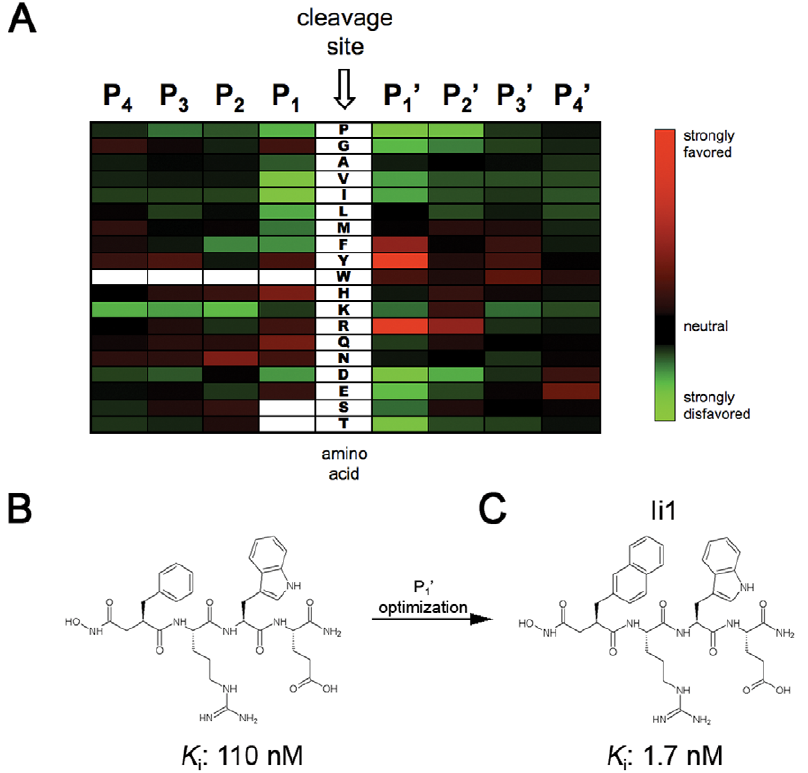
Figure 1. Cleavage-site specificity of IDE and first-generation inhibitors derived therefrom. A , Heat map showing amino acids favored ( red ) or disfavored ( green ) by IDE at different positions relative to the cleavage site, as determined from proteomic analysis of peptide mixtures. B , Conventional peptide hydroxamate synthesized on the basis of the analysis in ( A ). C , Structure of inhibitor Ii1, incorporating optimized P 1 ’ moiety deduced from analysis of a focused library of retro-inverso peptide hydroxamates (see Figure